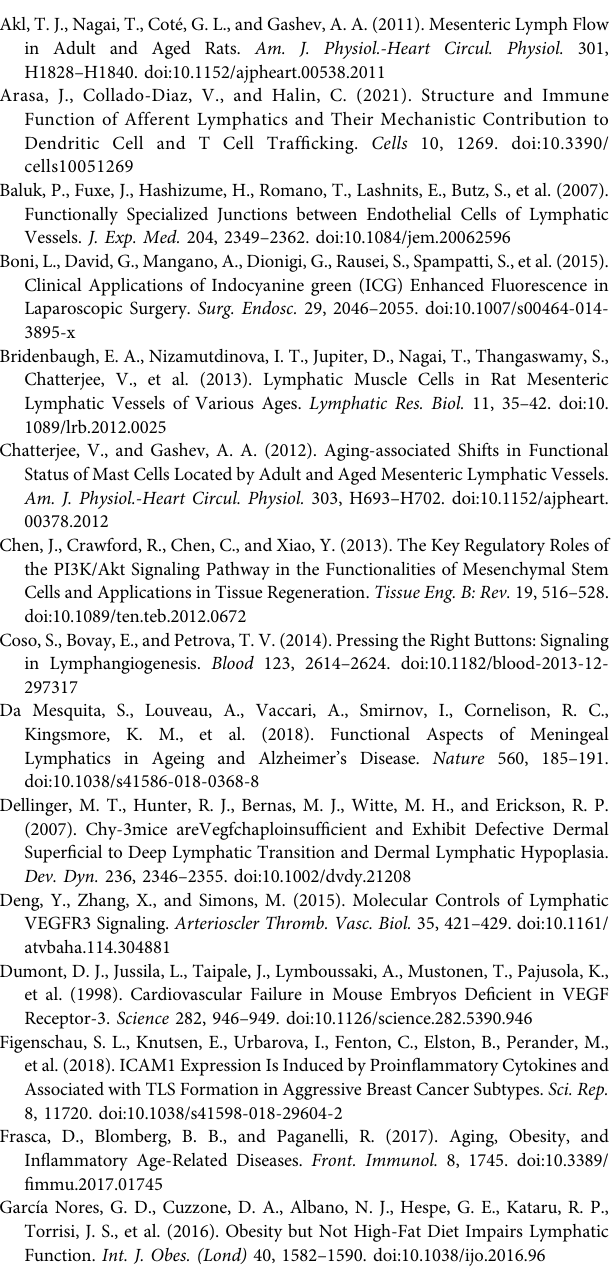
n = 5 mice per group in all experiments. All quanti fi cations are mean ± SD, unpaired Student ’ s t test. Supplementary Figure S3 | Peri-lymphatic of myeloid cells and nitrosative stress. (A) Representative low magni fi cation images of young and aged skin stained for lymphatics (LYVE-1) and myeloid cells (CD11b). (B) low magni fi cation images of peri-lymphaticnitrosativestressvisualizedbyN-TYRimmunostaining. n =5miceper group in all experiments. Supplementary Figure S4 | Aging causes increased peri-lymphatic antibody deposition. (A) Representative confocal images of ear skin sections stained for